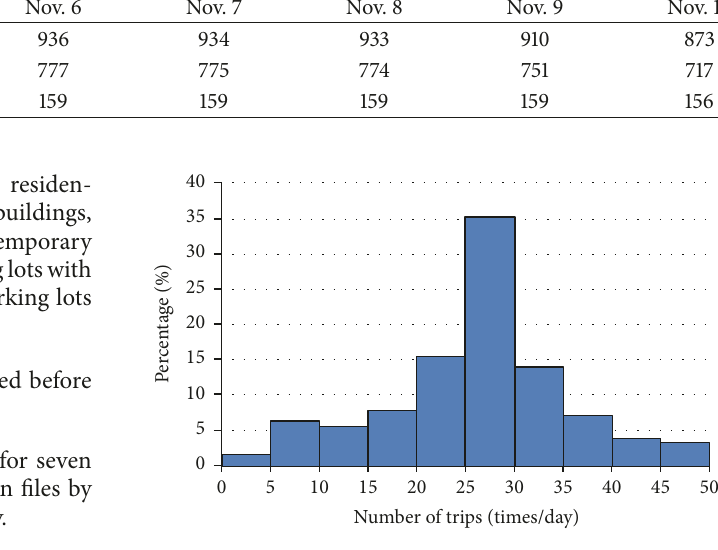
Figure 2: The distribution of number of trips for taxi in